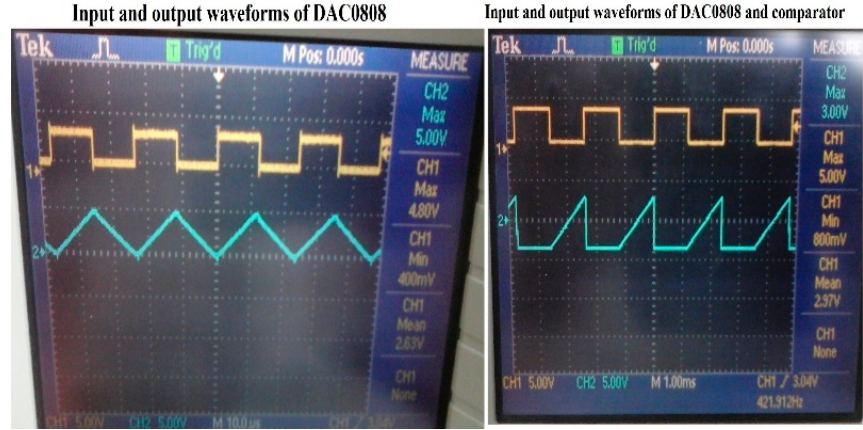
Figure 12. Input and output waveforms of DAC0808, Comparator.